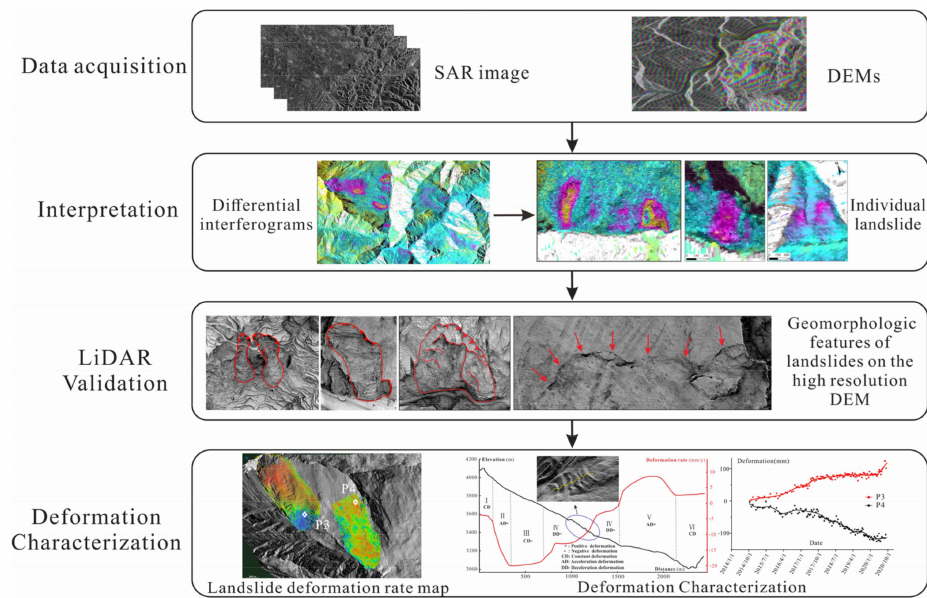
Figure 1. The adopted workflow for mapping and characterizing landslides in a large